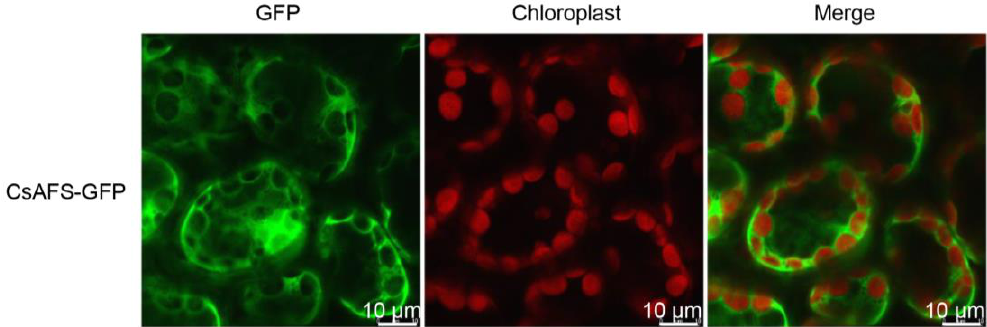
Figure 4. Subcellular localization of CsAFS protein in transformed N. benthamiana . Green fluorescence indicated CsAFS-GFP fusion protein, and red fluorescence indicated the chloroplast auto-fluorescence.